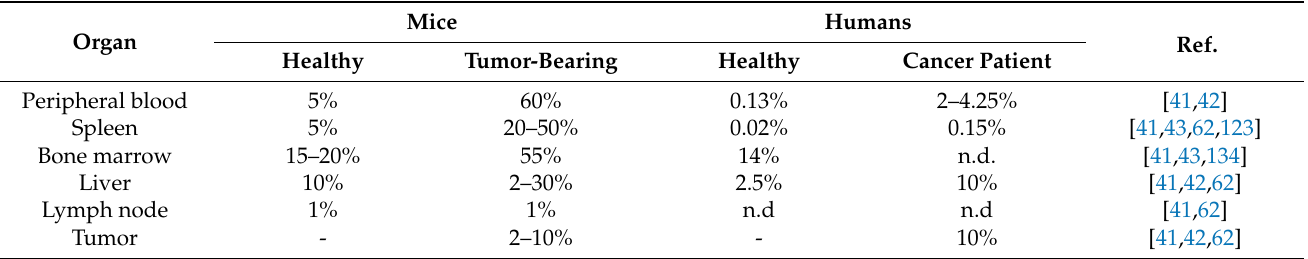
Table 6. The frequency of EPCs in tumor-bearing mice and cancer